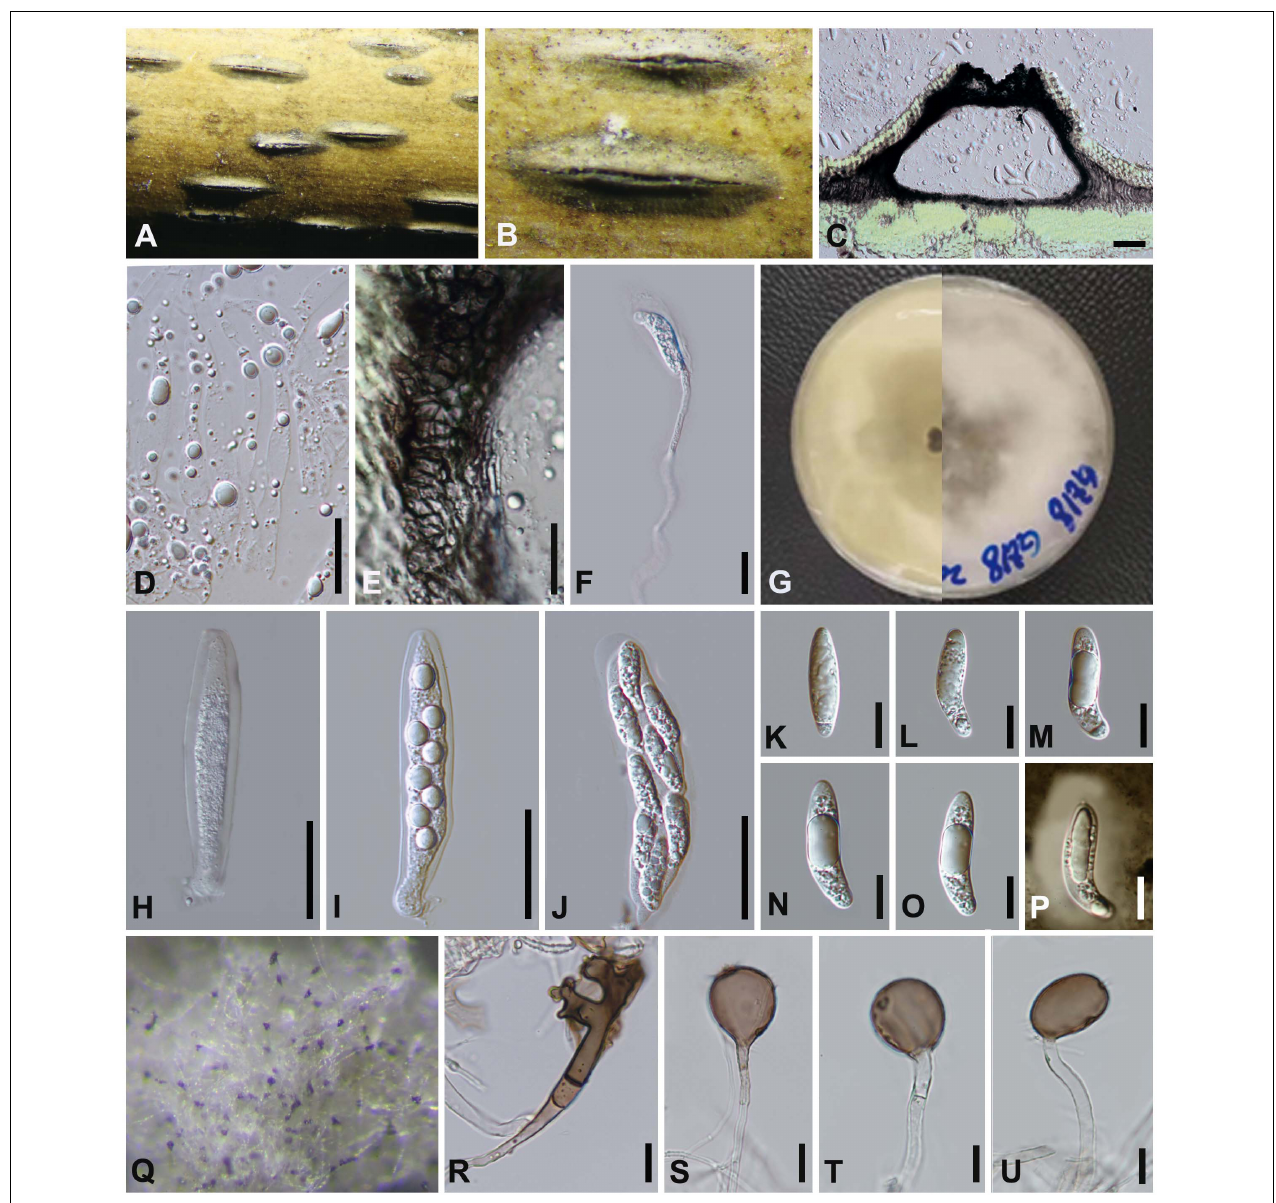
FIGURE 9 | Arthrinium pseudoparenchymaticum (GZAAS 20–0115) (A,B) Appearance of stromata on bamboo host. (C) Vertical section of stroma. (D) Paraphyses. (E) Peridium. (F) Germinating ascospore. (G) Culture. (H–J) Asci. (K–O) Ascospore. (P) Ascospore in Indian ink and present clear gelatinous sheath. (Q) Colony on WA producing conidia masses. (R) Dentate conidia. (S–U) Conidiogenous cells giving rise to conidia. Scale bars: (C) = 50 µ m. (D–F) = 20 µ m. (H–J) = 30 µ m. (K–P) = 15 µ m. (R–U) = 15 µ m.